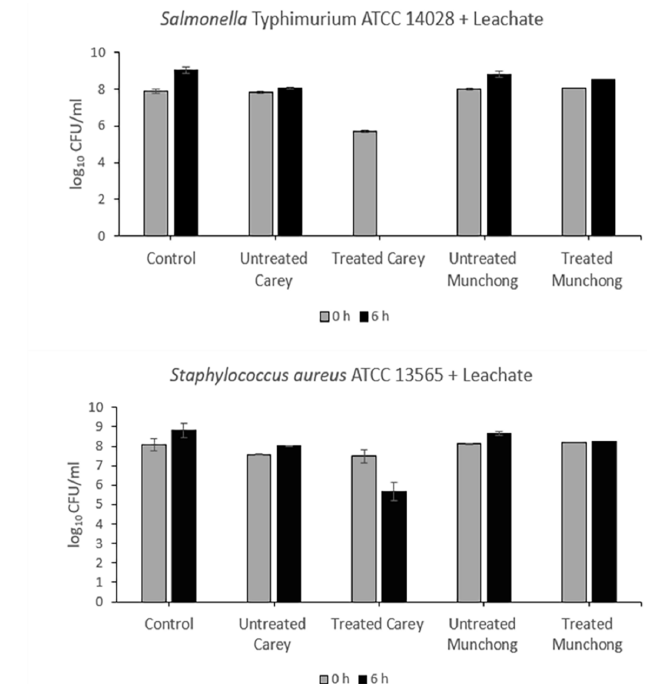
Figure 1. Antibacterial activity of untreated and treated clay leachates of Carey and Munchong soils following 6 h exposure to clay leachates (500 mg/mL), with sterile deionized water as control: ( a ) Viability of Salmonella typhimurium ATCC 14028; ( b ) Viability of S. aureus ATCC 13565.